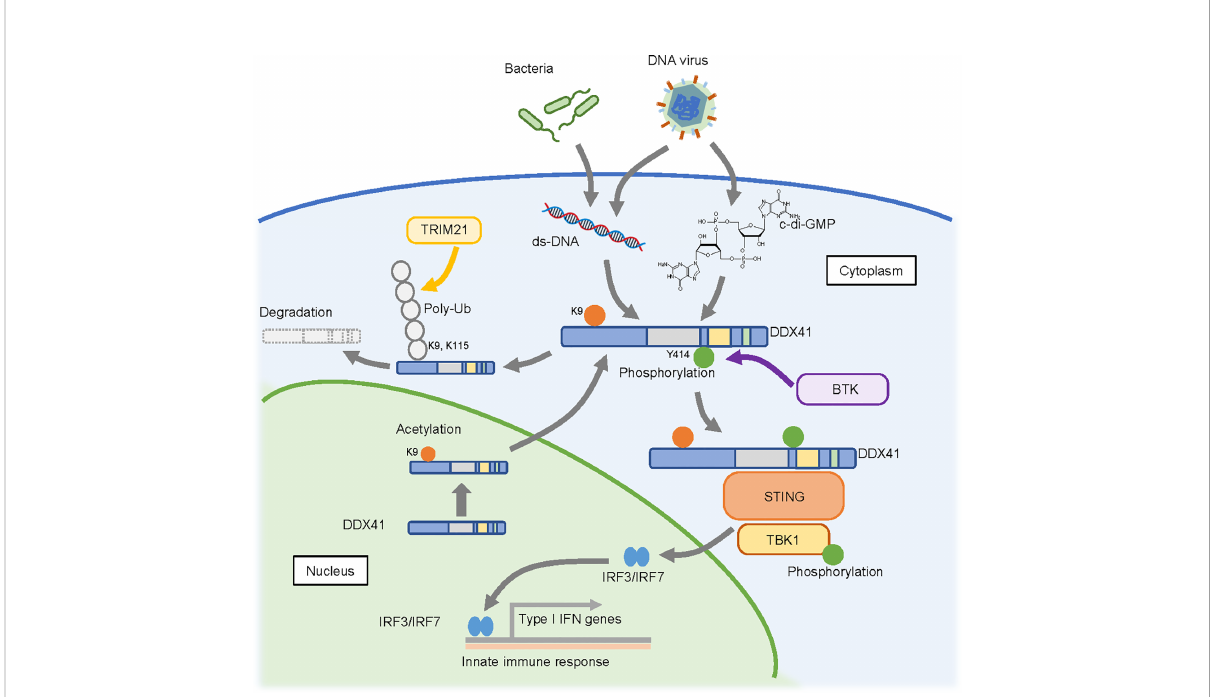
FIGURE 3 Possible cytosolic function of DDX41 as a nucleic acid sensor. DDX41 is exported to the cytoplasm in a nuclear localizing signal (NLS)- acetylation dependent manner and is activated by BTK-mediated phosphorylation. It senses double-strand DNA or c-di-GMP released from pathogens that invade the cytoplasm, and activates innate immune reactions through the STING-TBK1 axis. DDX41 is also reportedly degraded by TRIM21 mediated poly-ubiquitination